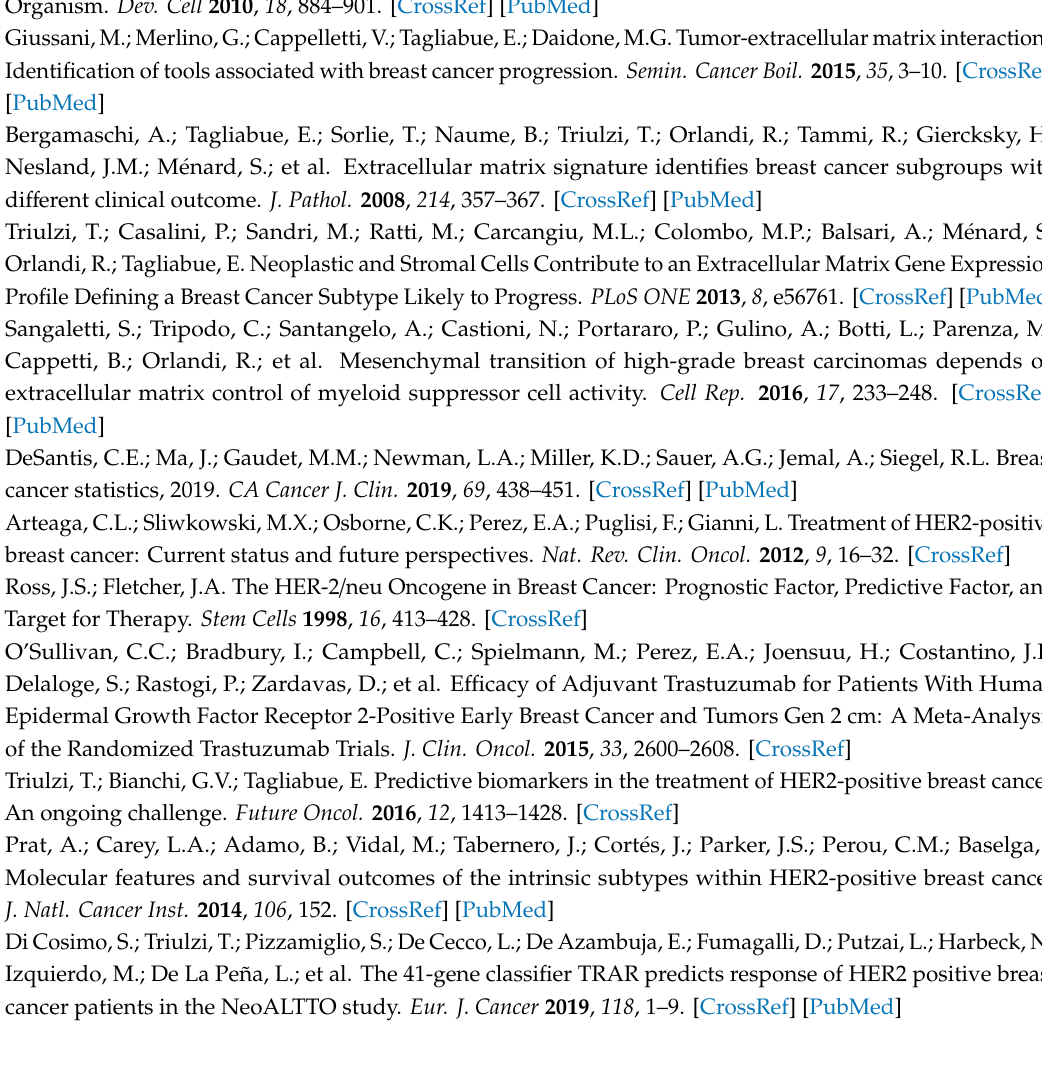
Figure S1: Association between ECM3 and PAM50 and TRAR. Figure S2: Association between ECM3 and immune metagenes. Figure S3: Body weight of mice treated or not with trastuzumab Table S1: Univariate proportional hazards analyses of DFS. Table S2: Multivariate proportional hazards analysis of DFS in NKI dataset. Table S3. Multivariate proportional hazards analyses of overall